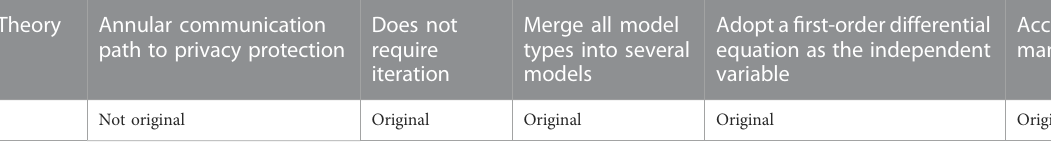
TABLE 2 Innovation of this study. Theory